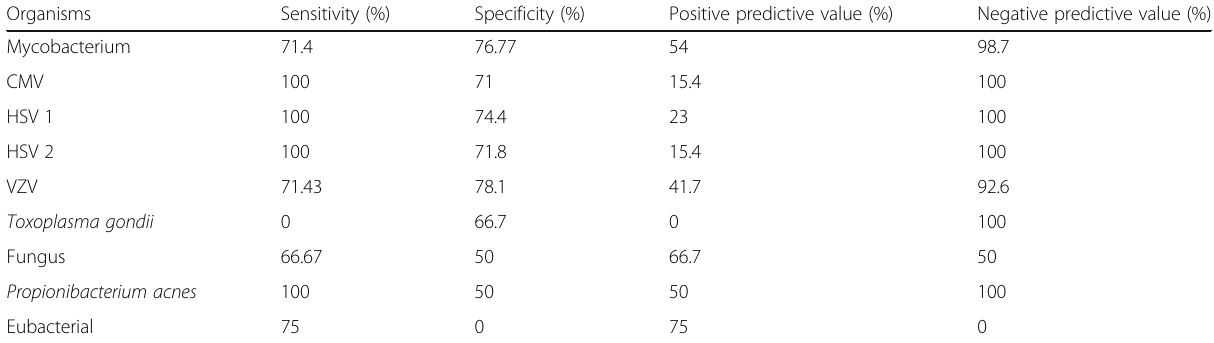
Table 4 Individual organism sensitivity, specificity, and predictive value Organisms